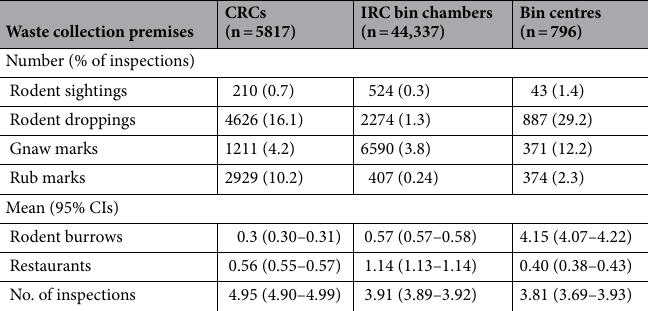
Table 1. Characteristics of central refuse chutes, individual refuse chute bin chambers and bin centres in Singapore, 2019 to 2020.